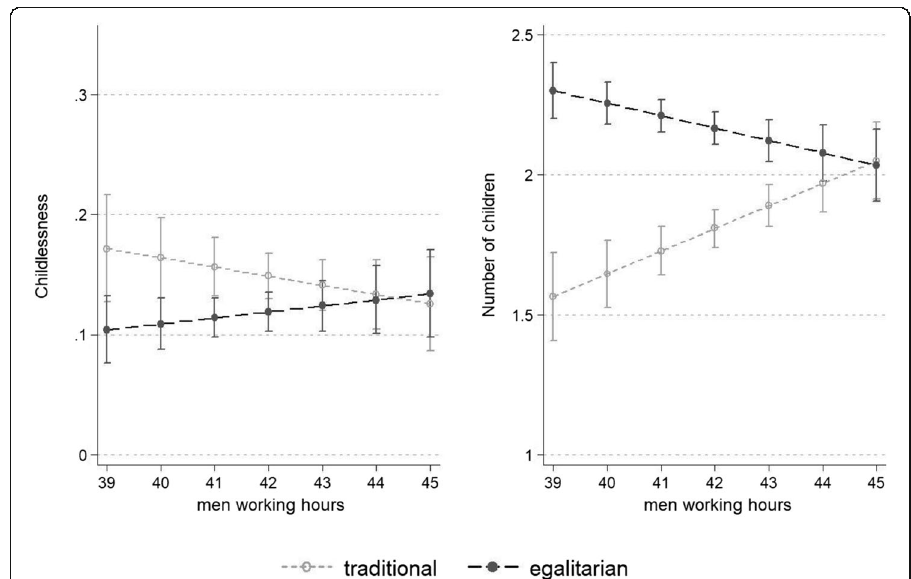
Fig. 6 Predicted probabilities of being without children (left panel) and predicted number of children (right panel) by the number of hours worked in the main job by man and different levels of gender egalitarianism. Source : EU-LFS 2005-2010, author ’ s elaboration. Note : Predictions refer to Tables 10 and 11 in the Appendix, models C4c and N4c. 90% confidence intervals